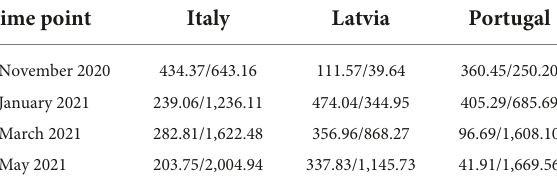
TABLE 1 Daily new confirmed COVID-19 cases per million people, 7-day rolling average/cumulative confirmed COVID-19 deaths per million people 2020/2021 in Italy, Latvia, and